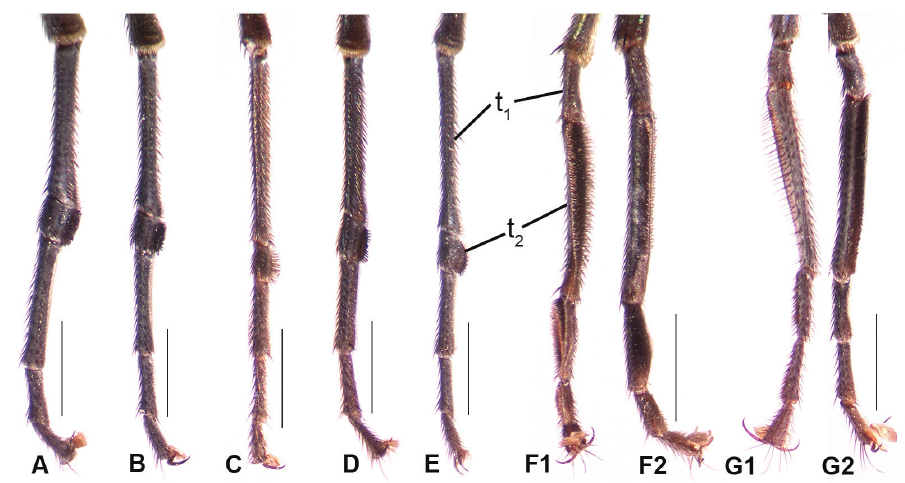
Figure 3. Front tarsi of males, A Liancalus pterodactyl sp. n., medial view B L. hydrophilus Aldrich, medial view C L. genualis Loew, medial view D L. limbatus Van Duzee, medial view E L. sonorus sp. n., medial view F1 L. querulus Osten Sacken, ventral view F2 L. querulus , medial view G1 L. similis Aldrich, ventral view G2 L. similis , medial view. Scale bars = 0.5 mm. t